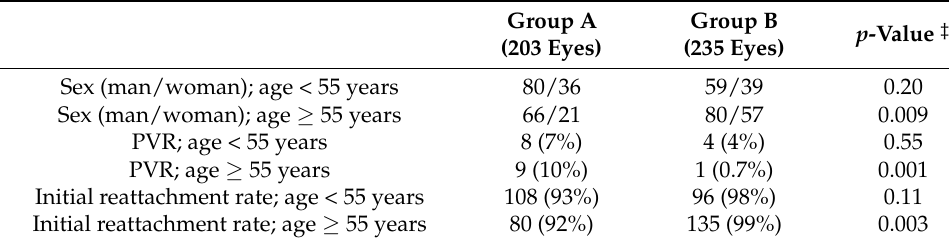
Table 5. Subgroup analysis.